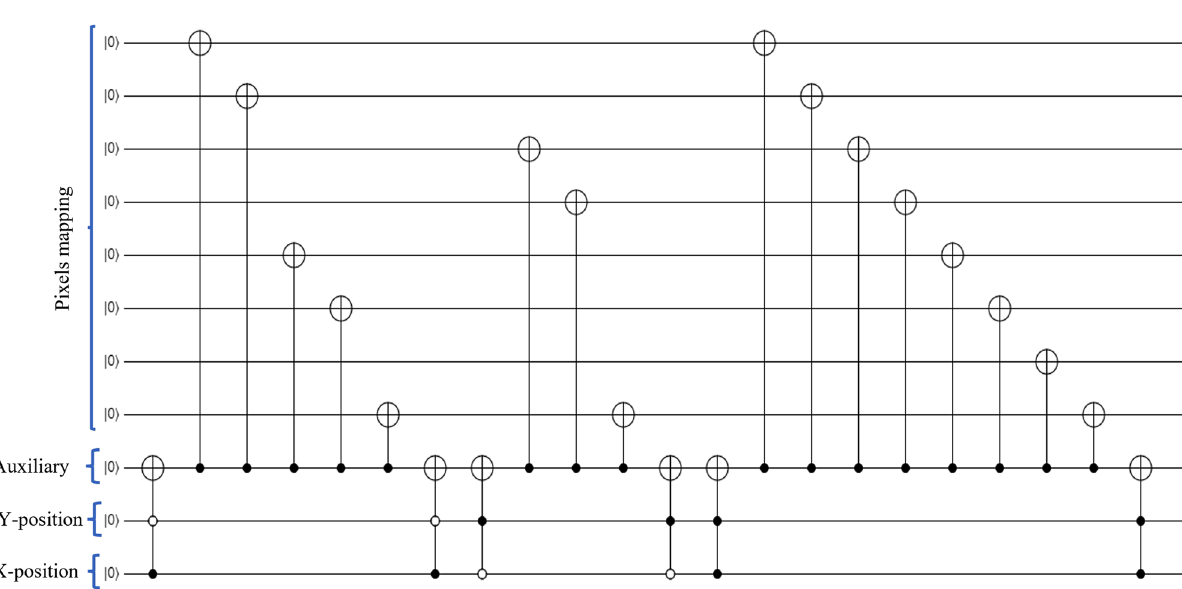
Figure 3. Example of decomposition circuit using Toffoli